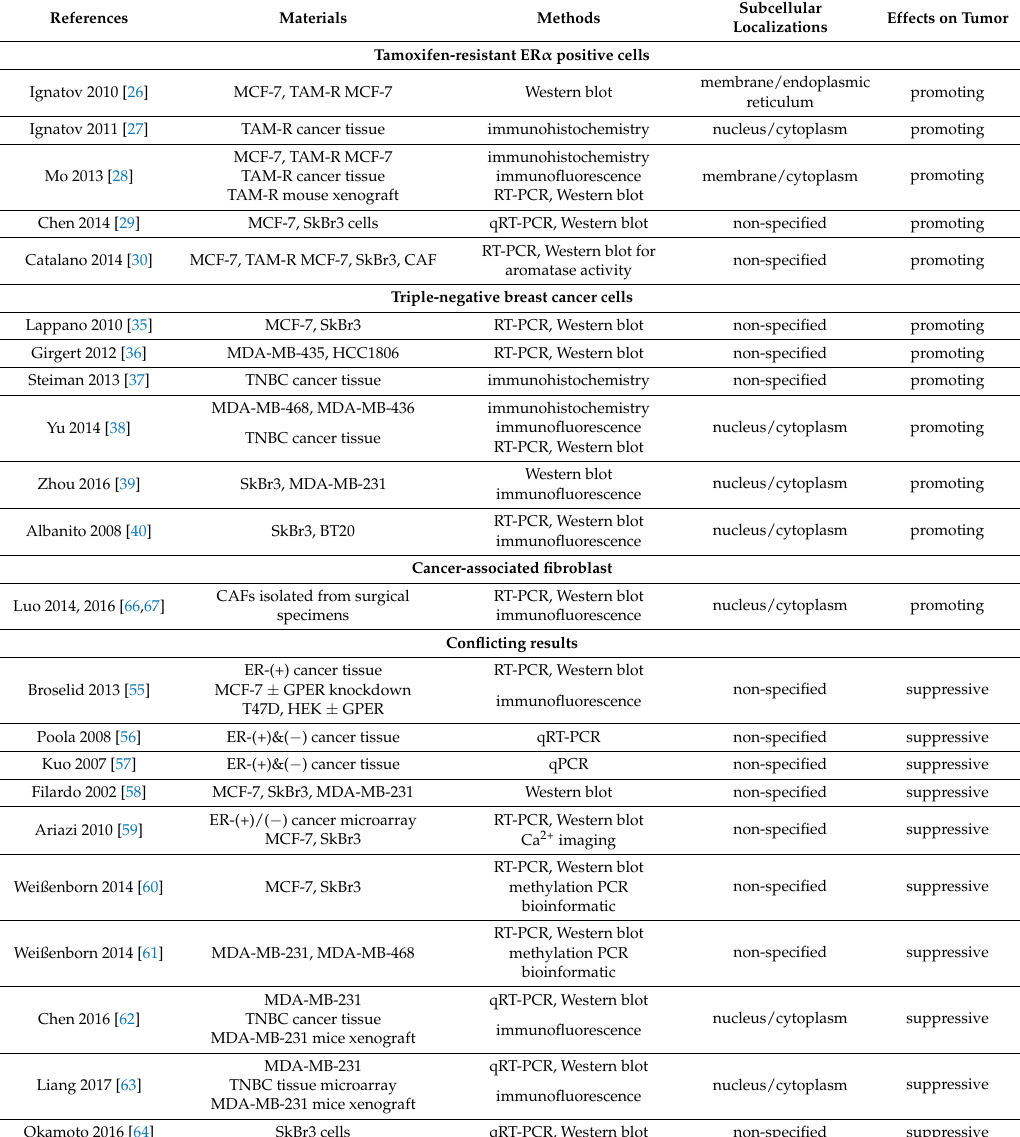
Table 1. G-protein coupled estrogen receptor (GPER) as a prognosticator in breast cancer cell lines and